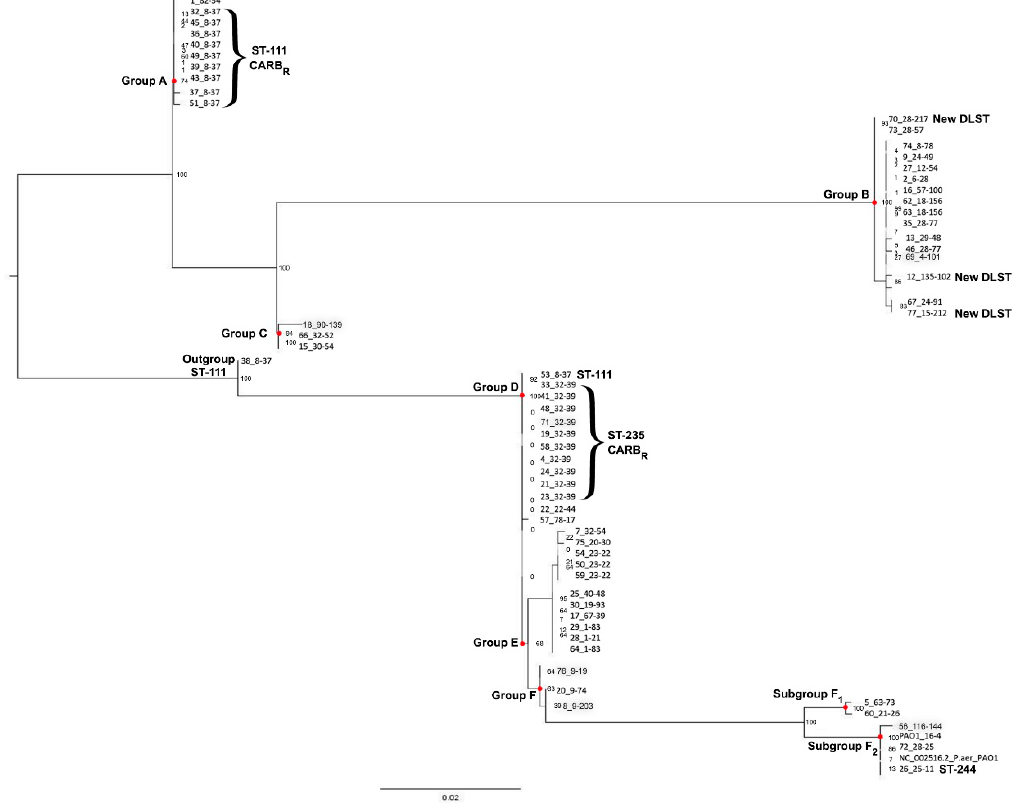
Figure 3. ML phylogeny of the P. aeruginosa isolates based on the 62 oprD sequences of the tested isolates; the Ref. seq.: NC_002516.2_P.aer_PAO was used to align the sequences. Correlation of the oprD-groups with the DLST-types is also presented.